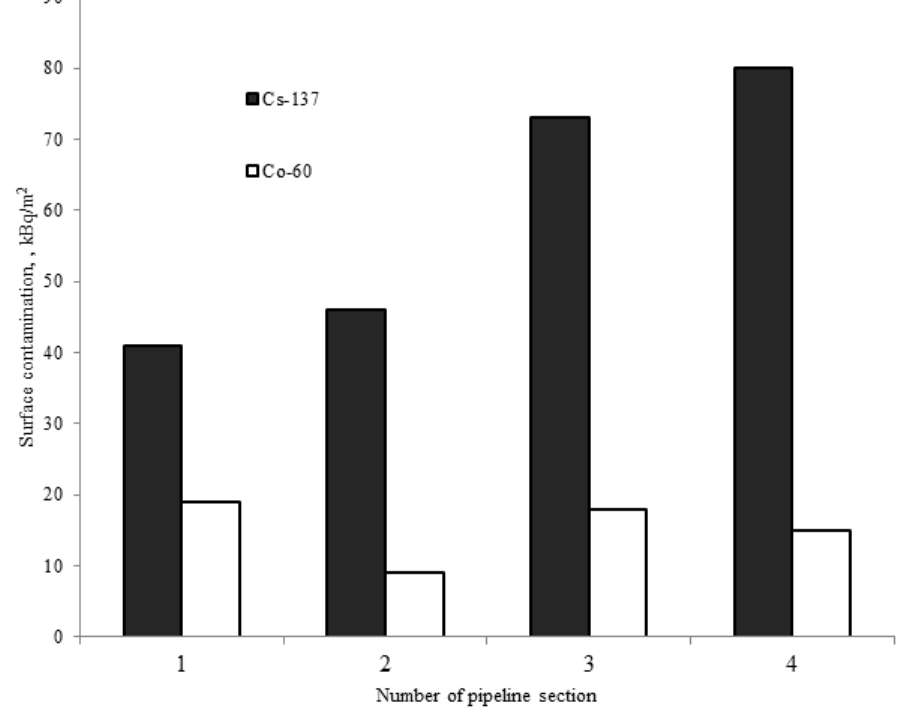
Figure 6. Radioactive contamination on the surface of the coolant pipeline specimen.